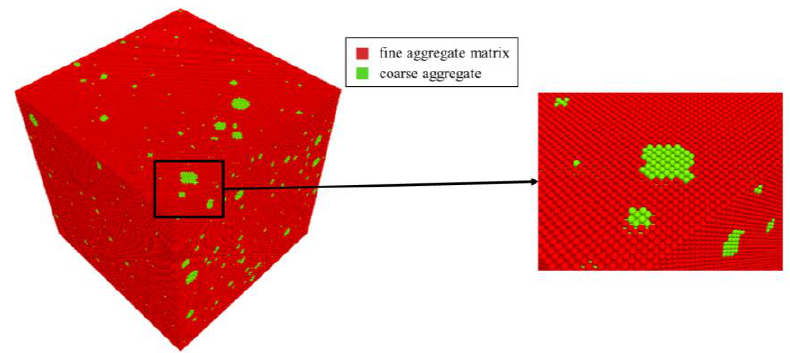
Figure 5. Example of small volume units with single material properties.